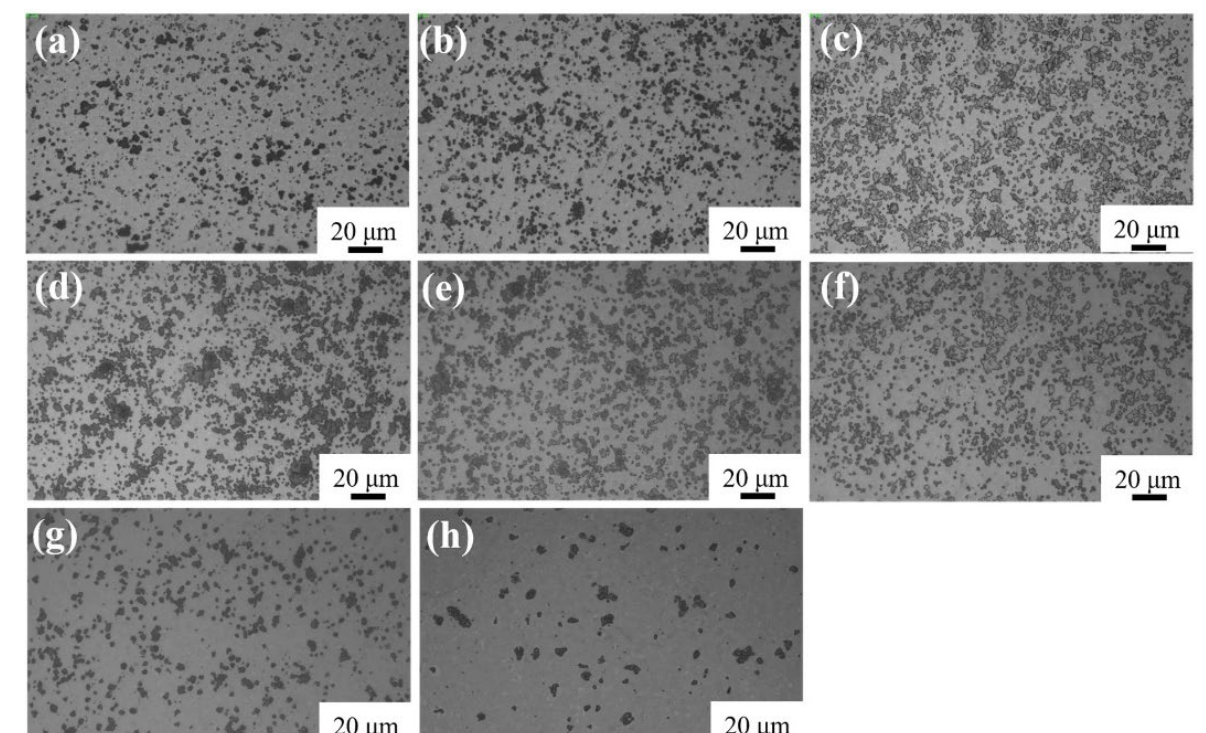
Figure 3. Optical microstructure of WC-13Co with different contents of Mo and C, ( a ) 0Mo-5.13C, ( b ) 1Mo-5.07C, ( c ) 2Mo-5.01C, ( d ) 2.5Mo-5.0C, ( e ) 2.5Mo-5.3C, ( f ) 2.5Mo-5.45C, ( g ) 2.5Mo-5.75C, ( h ) 2.5Mo-6.1C.